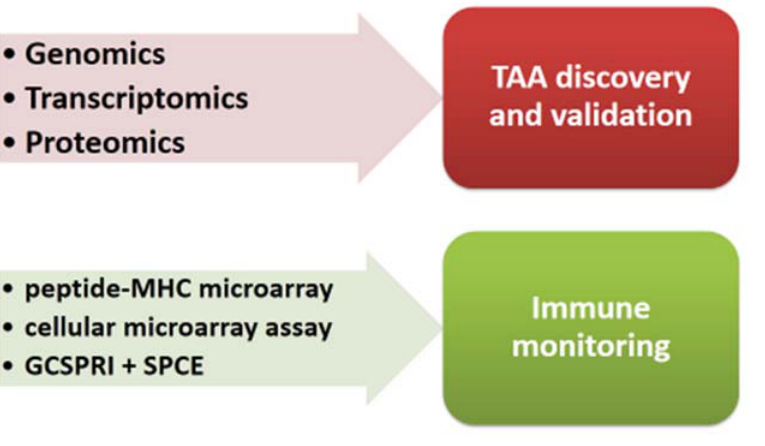
Figure 2. Systems vaccinology approach applied to cancer